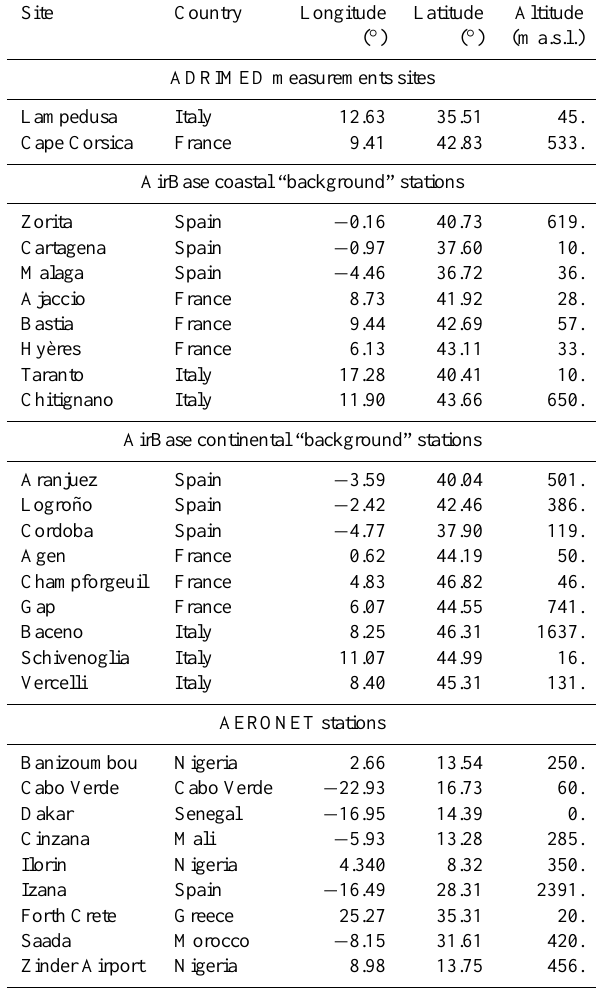
Table 1. Characteristics of the ADRIMED, AirBase and AERONET stations used in this study. Note that the AirBase Italian stations of Chitignano, Baceno, Schivenoglia and Vercelli provide daily averaged values, when all other stations provide hourly (but not regular) measurements. The altitude is in meters above sea